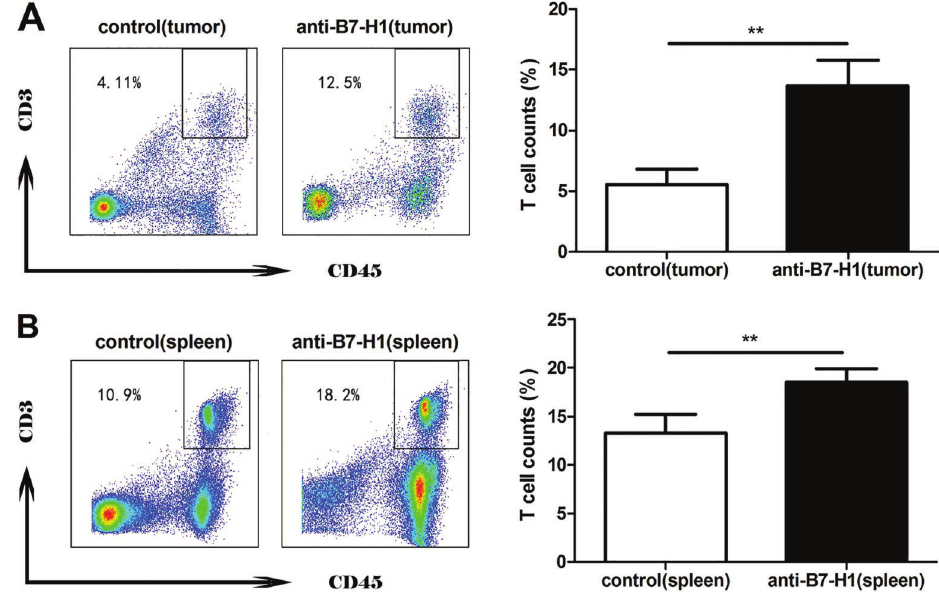
Figure 3. Representative fl ow graphs ( left ) and results of quantitative analysis ( right ). B7-H1-induced anti-tumorigenesis is associated with a signi fi cantly higher number of CD3 + CD45 + T cells in both xenograft tumors and spleens. Xenograft tumors ( A ) and mouse spleens ( B ) were isolated from either control or anti-B7-H1 mice, and digested into single-cell suspensions. The CD3 + CD45 + T-cell population was examined by fl ow cytometry. **P o 0.01, compared with the control group ( t